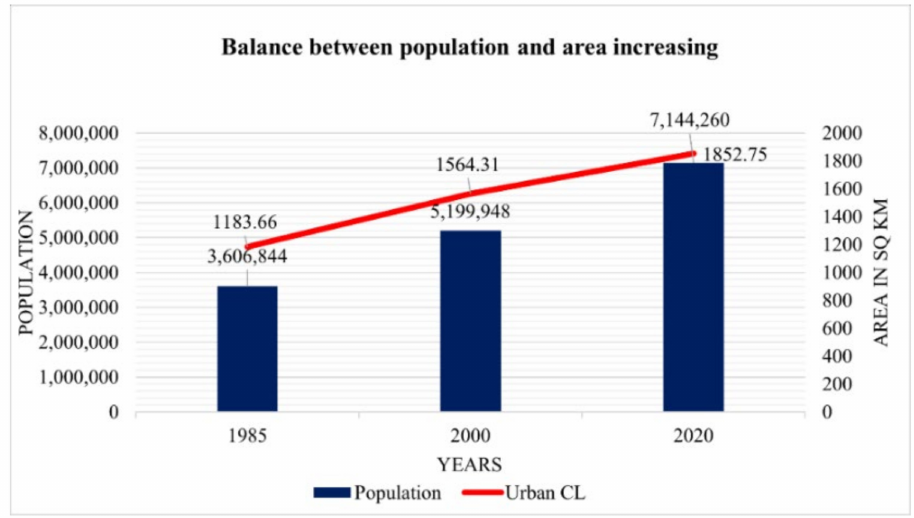
Figure 8. Year wise growth relationship between population growth and urban